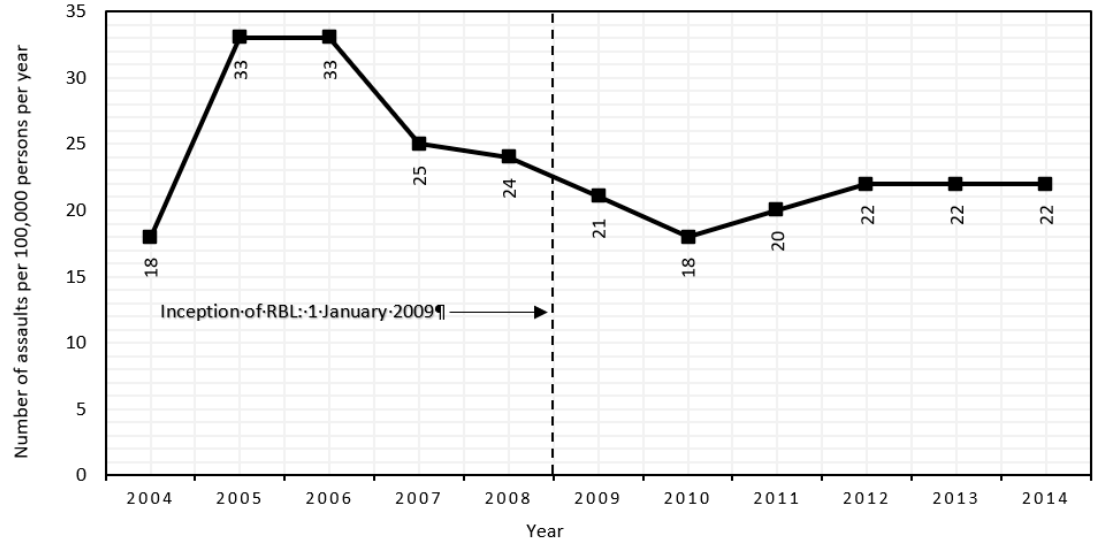
Figure 2 . Crude annual incidence rates of assault during “high alcohol hours” related to licensed premises .